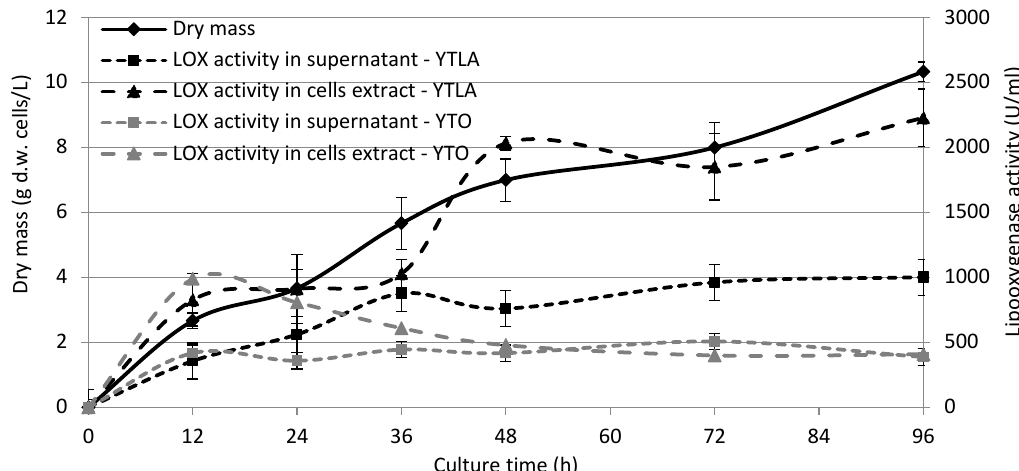
Figure 4. The dry mass of cells and lipoxygenase activity in cell extracts and supernatants during the growth of Yarrowia lipolytica in media with linoleic acid and olive oil.